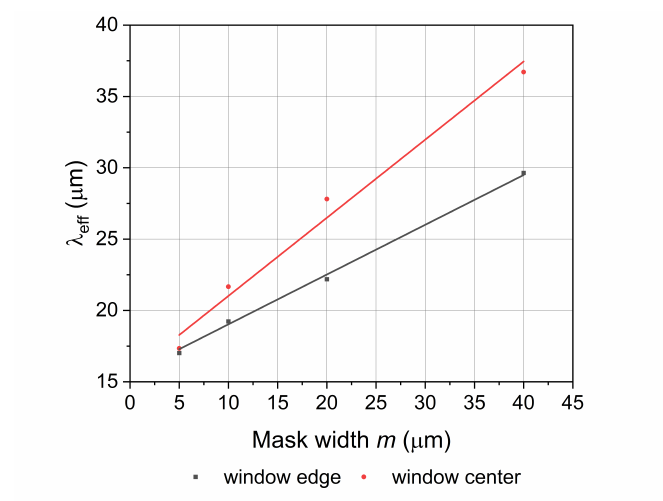
Figure 12. Effective diffusion length at the window edge and the window center as a function of the mask width λ ef f = f ( m ) .